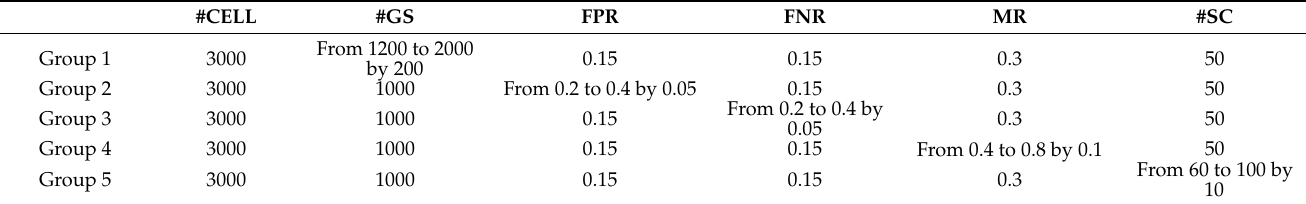
Table 1. Simulation parameters for datasets of five